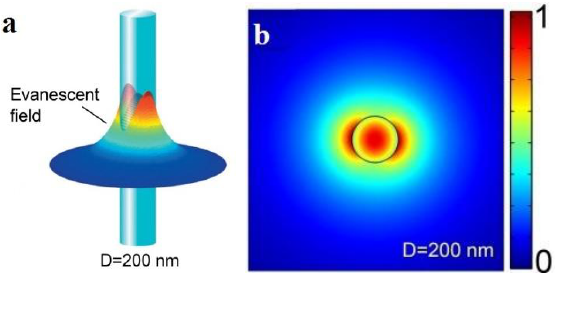
Figure 4. Z -direction Poynting vectors of a 400 nm diameter silica microfiber at 633 nm wavelength ( a ) in 3-D view; and ( b ) in 2-D view [3].